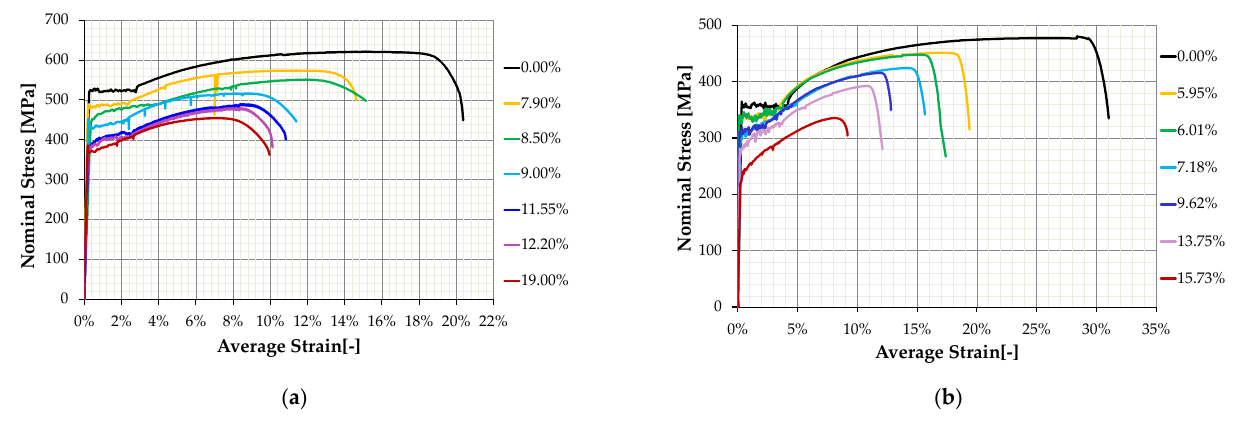
Figure 1. Comparison between the mechanical performance of steel reinforcements subjected to uniform corrosion: ( a ) ribbed bars, ( b ) smooth bars. The corrosion level is expressed in terms of mass loss.